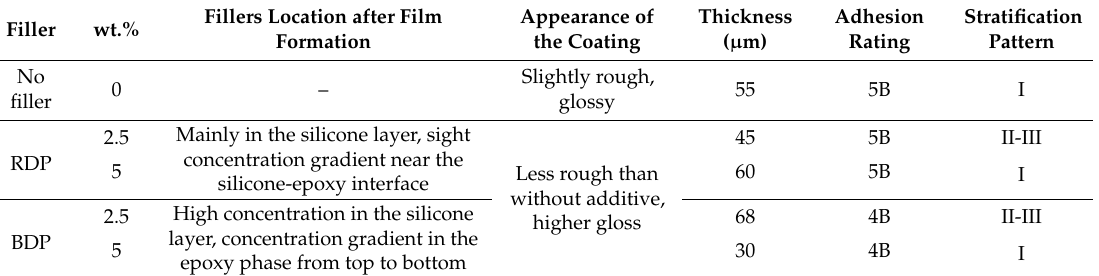
Table 1. Morphology and adhesion properties of the coatings containing or not phosphate additives. Fillers Location after Film Filler wt.% Formation